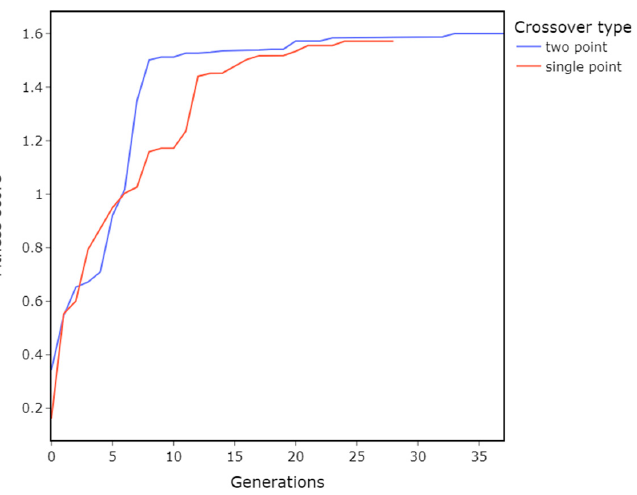
Figure 7. Impact of crossover operators on the GA’s performance. There is no significant difference between the two- and single-point crossovers.